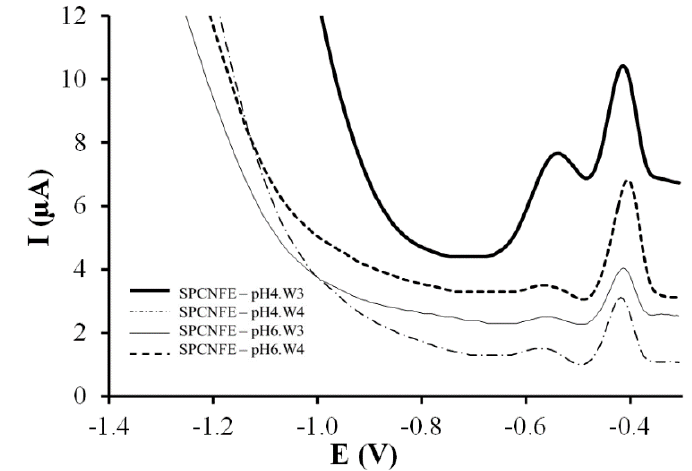
Figure 6. Stripping voltammetric measurements of the SPCNFE modified with Ag-NPs obtained from different synthesis pH conditions and washing suspensions for the simultaneous detection of Cd(II) and Pb(II) at 77 µg L −1 and pH 4.5.